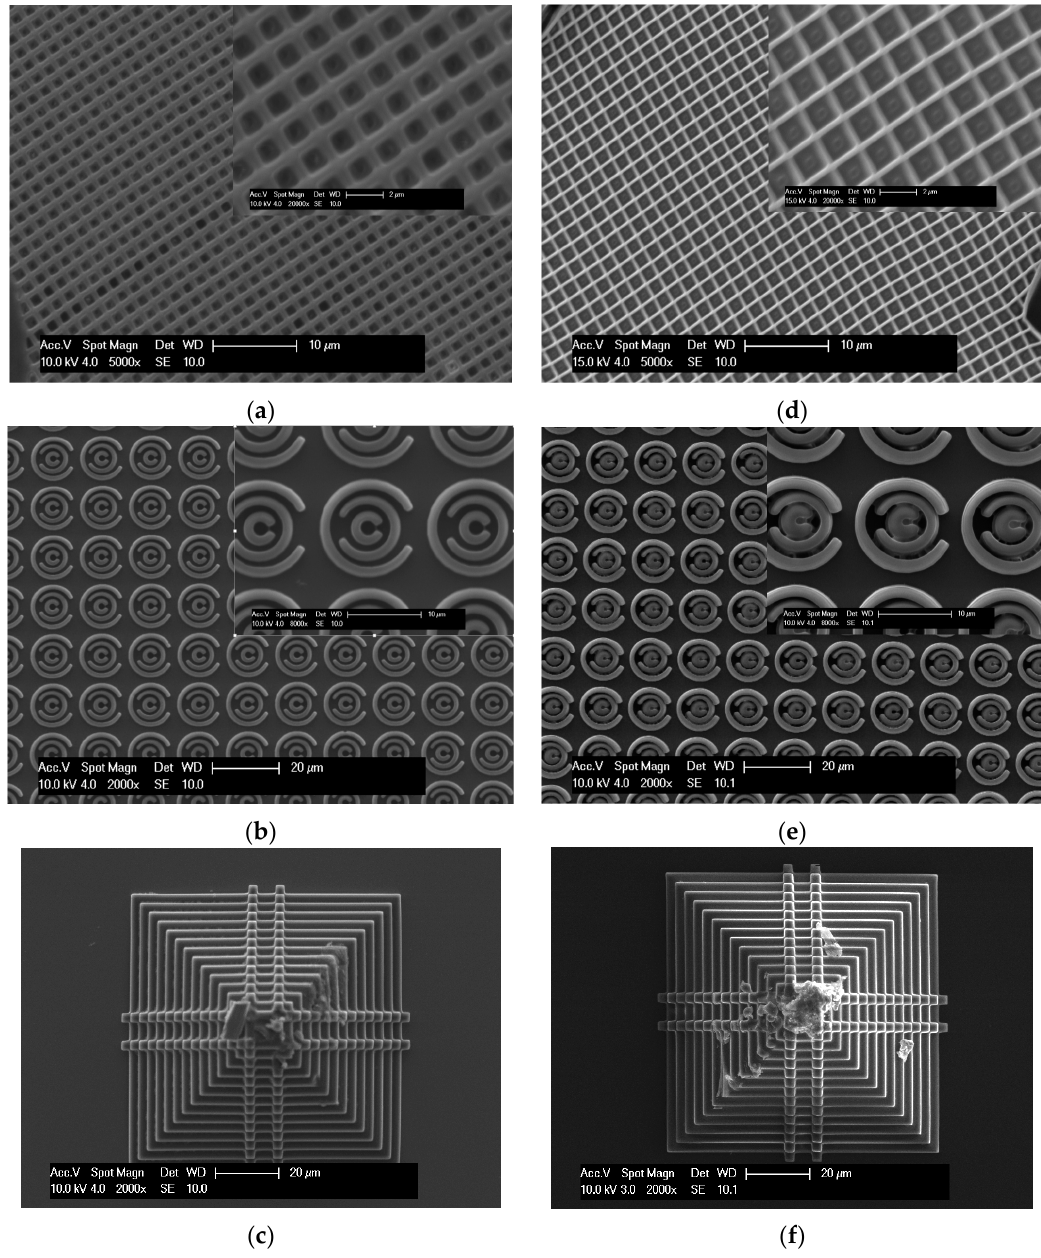
Figure 2. SEM images of 2D and 3D fabricated structures using Formulations 1 and 4. ( a – c ) show the results of fabricating increasingly more complex structures with Formulation 1 (Table 1); ( d – f ) show the results of fabricating increasingly more complex structures with Formulation 4. Table 2. The minimum laser output power (mW) for each formulation.